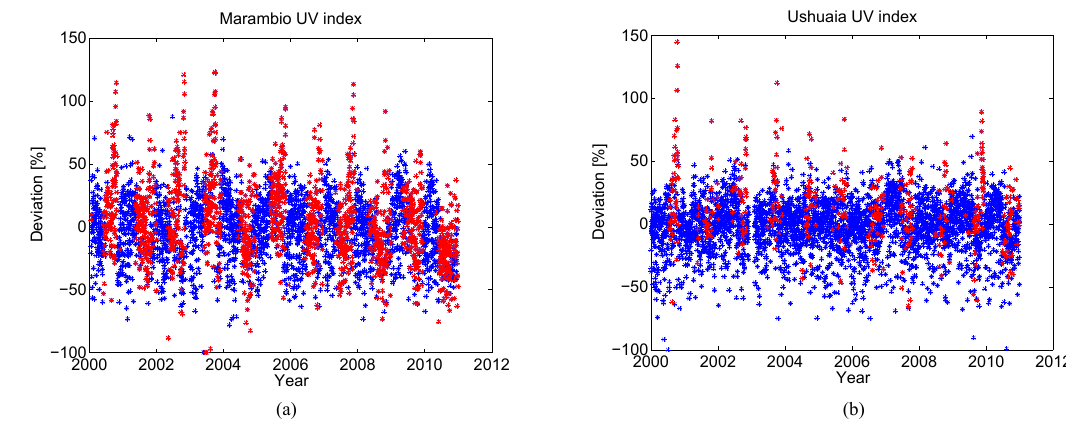
Figure 10. Deviation from the daily climatology of maximum UV index in (a) Marambio and (b) Ushuaia for the years 2000–2010. Days for which the station was inside the polar vortex are indicated with red symbols, the others in blue.